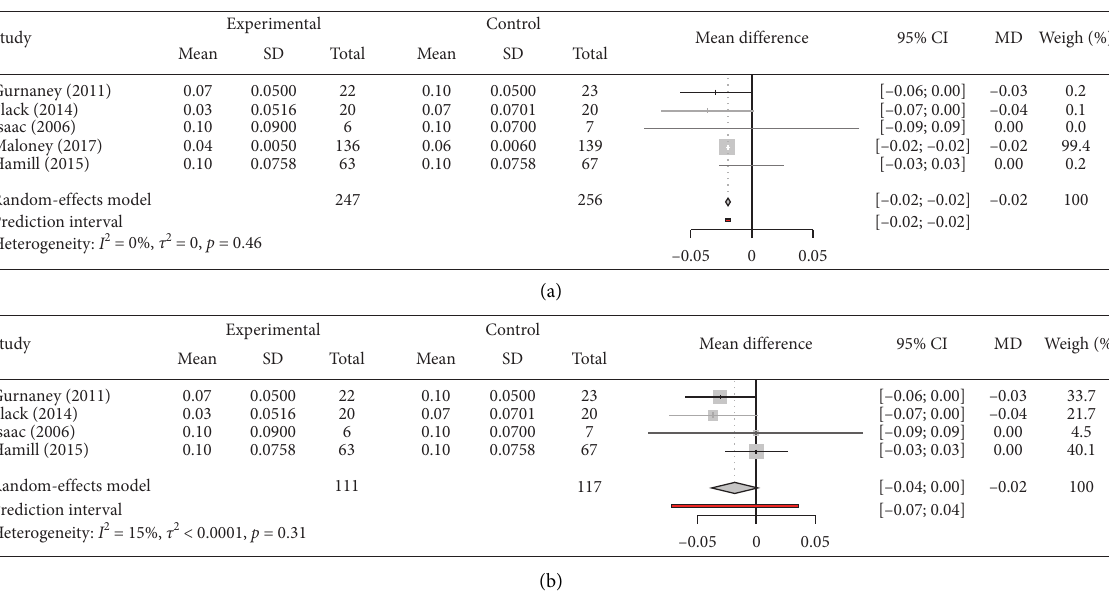
Figure 3: Primary outcomes. Forest plot with effect size, estimated heterogeneity ( I 2 and τ 2 ) and confidence intervals (CIs) for meta-analysis evaluating total morphine consumption in the postoperative anaesthetic agents, RPV and BPV rectus sheath block of all groups, the effect of BPV and RPV on postoperative pain (a) and (b) except Maloney’s study. The column “Mean” represents the mean dosage of opioid use (mg/ kg), while “Total” stands for the patient number included in the studies. The square symbol on forest plot denotes the weighted mean difference for individual studies, with 95% CI of the difference represented as a solid line. The size of square and thickness of the 95% CI line resemble sample size. WMD: weighted mean difference; RPV: ropivacaine; BPV: bupivacaine.